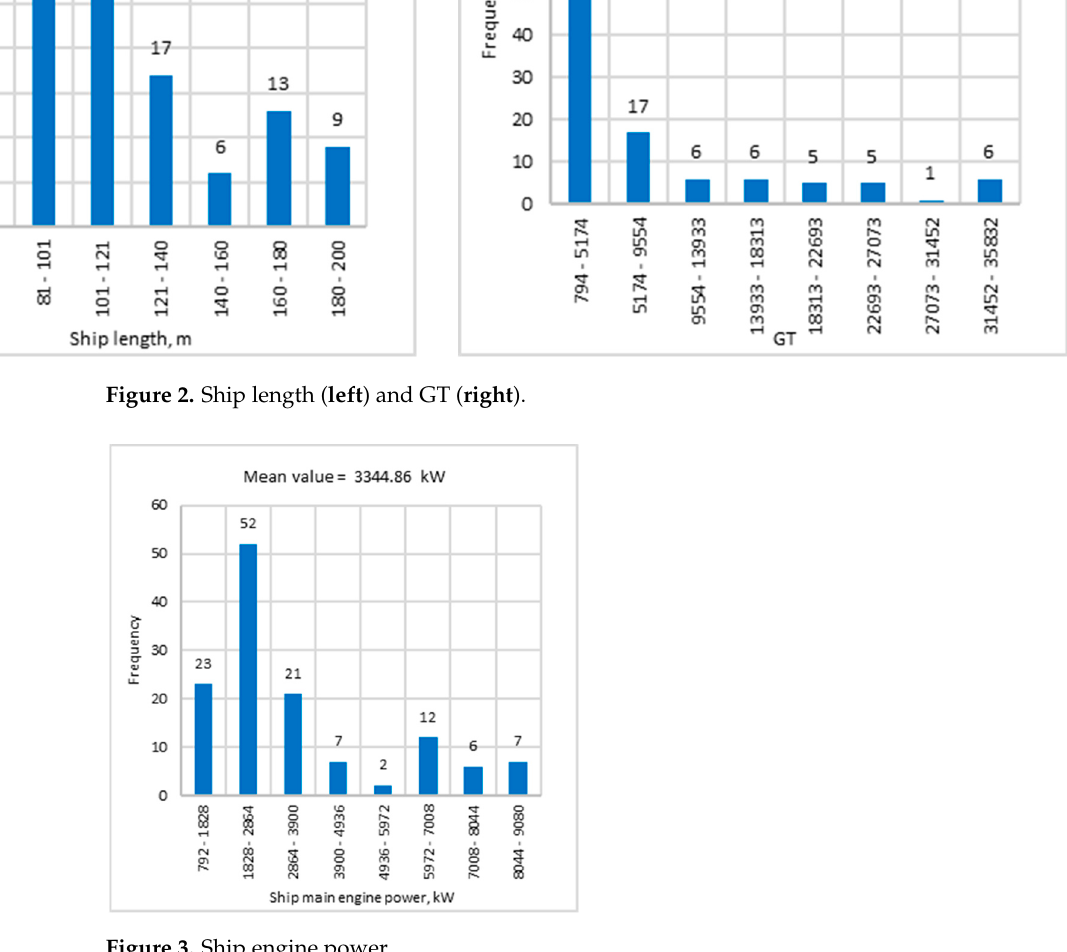
Figure 3. Ship engine power.